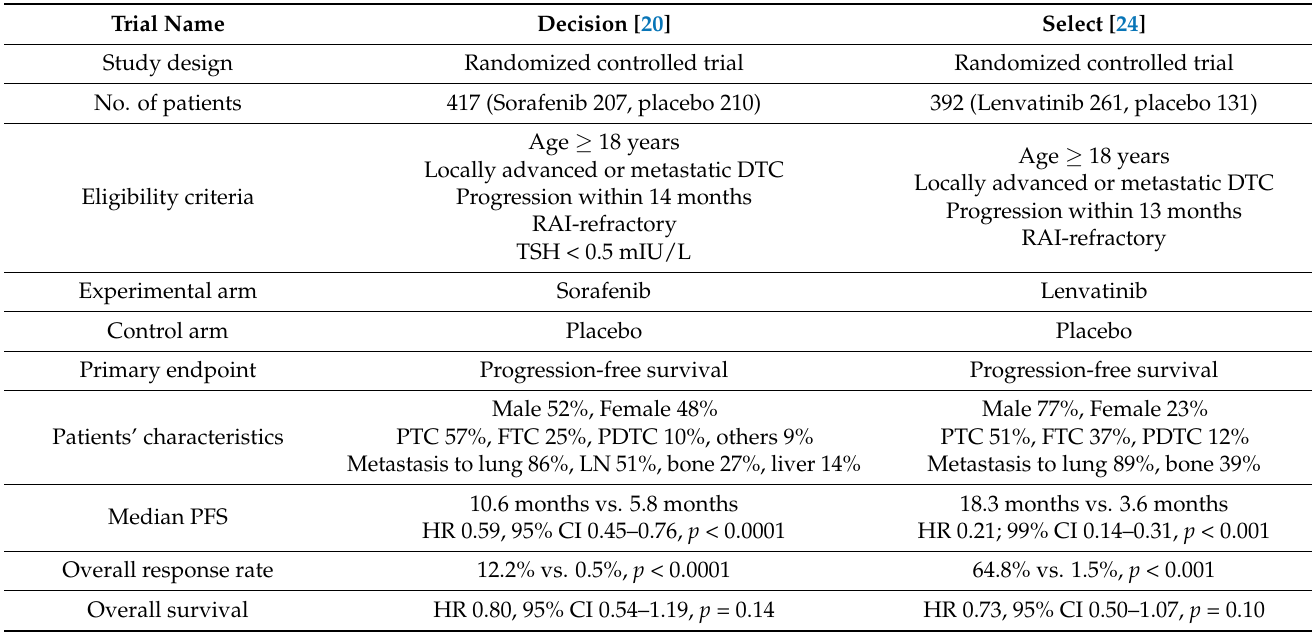
Table 1. Summary of the pivotal phase 3 clinical trials of MKIs in patients with